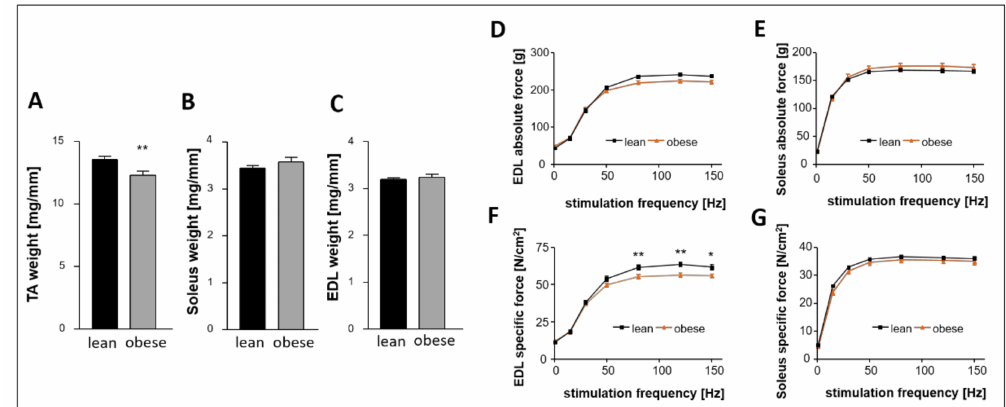
Figure 2. Basic characterization of 20-week-old lean and obese ZSF1 rats—skeletal muscle weight and function. Muscle weight of ( A ) TA muscle, ( B ) Soleus muscle, and ( C ) EDL muscle. ( D , E ) Absolute force measured for EDL ( D ) and Soleus ( E ) and specific force measured in EDL ( F ) and Soleus ( G ). n = 10 for each group. Lean and obese animals were compared by 2-sided Student’s t -test of equal variances. * p < 0.05, ** p < 0.01 vs. lean, respectively.